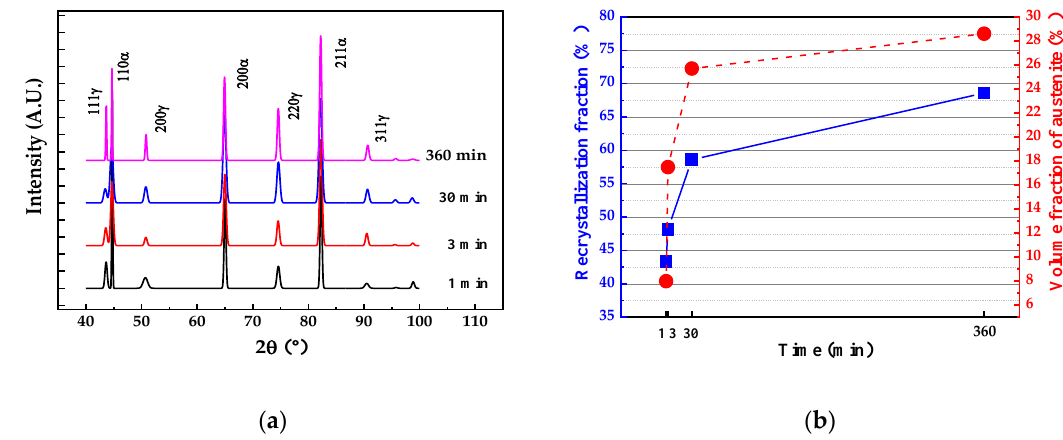
Figure 7. ( a ) XRD diffraction patterns and ( b ) the changes in the austenite volume fraction and recrystallization of the matrix with intercritical annealing time.